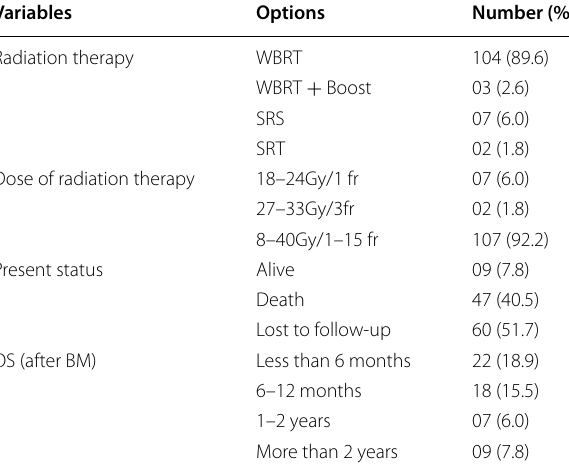
Table 1 Clinical characteristics of patients with BM ( n